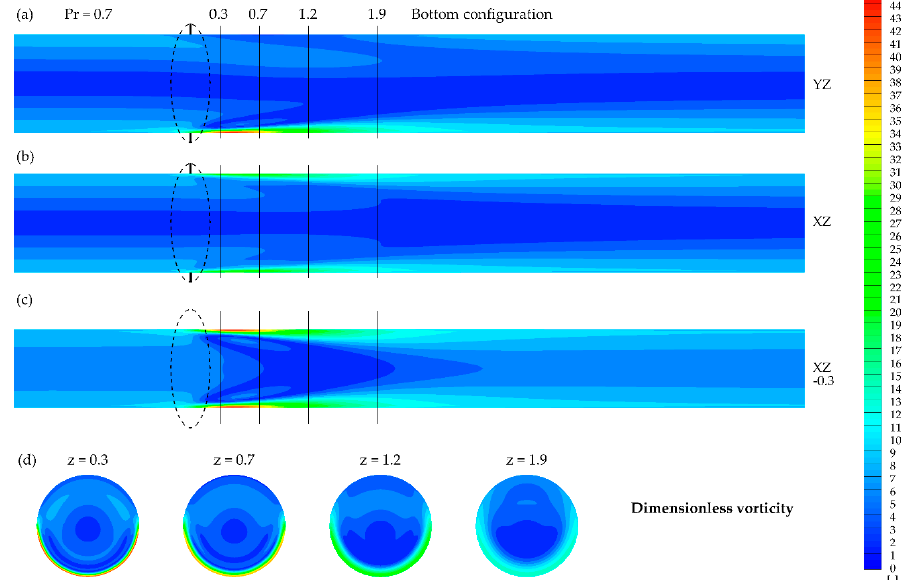
Figure 13. Dimensionless vorticity contours obtained for Pr = 0.7 and bottom configuration in the presence of the magnetic field at: ( a ) YZ plane, ( b ) XZ plane, ( c ) XZ plane ( y = − 0.3), ( d ) XY planes at given z .